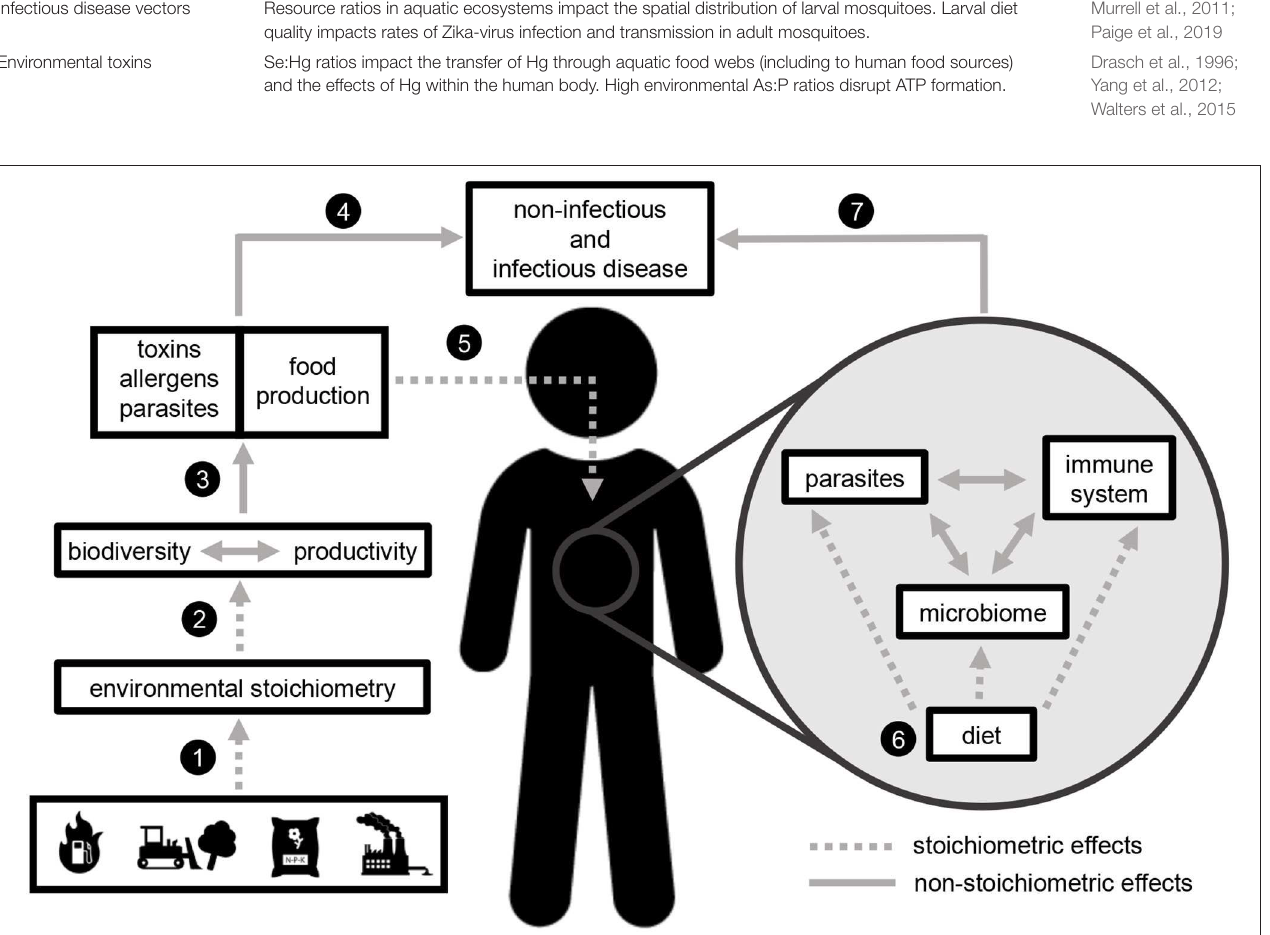
FIGURE 1 | A stoichiometric framework linking global change with human health. Stoichiometric effects (ecological processes mediated by elemental ratios, dashed lines) occur at two scales: in the external environment (to the left of the human figure) and within the human body (gray circle to the right of the human represents internal processes, especially diet-mediated processes within the gut). Global environmental changes (icons represent fossil fuel combustion, land use change, fertilizer application, and industrial pollution) alter the absolute (concentration) and relative (ratios) availability of elements in the environment (1). Environmental stoichiometry impacts the key ecosystem processes of biodiversity and productivity (2). Both of these processes contribute to toxin, allergen, and parasite production (3), all of which can impact human health directly by causing non-infectious and infectious disease (4). Stoichiometric effects on biodiversity and productivity also determine food production in both managed (e.g., agricultural) and unmanaged (e.g., marine and freshwater) systems (3). The quantity and quality of food production can impact human health directly (4), but these impacts may be mediated by stoichiometric effects occurring within the human body (5). Elemental ratios in human diet impact the function of parasites, the non-pathogenic microbiome, and the immune system (6), which collectively influence both non-infectious and infectious disease